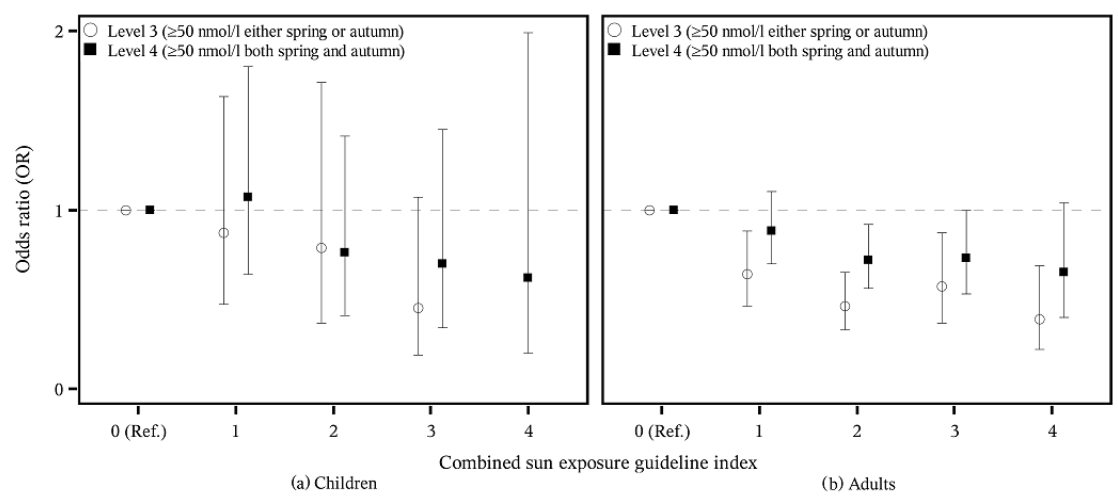
Figure 3. Adherence to the combined sun exposure guideline index and odds ratio (OR and 95% CI) of having adequate/high vitamin D (levels 3 and 4) among children, n = 569 ( a ) and adults, n = 2625 ( b ).